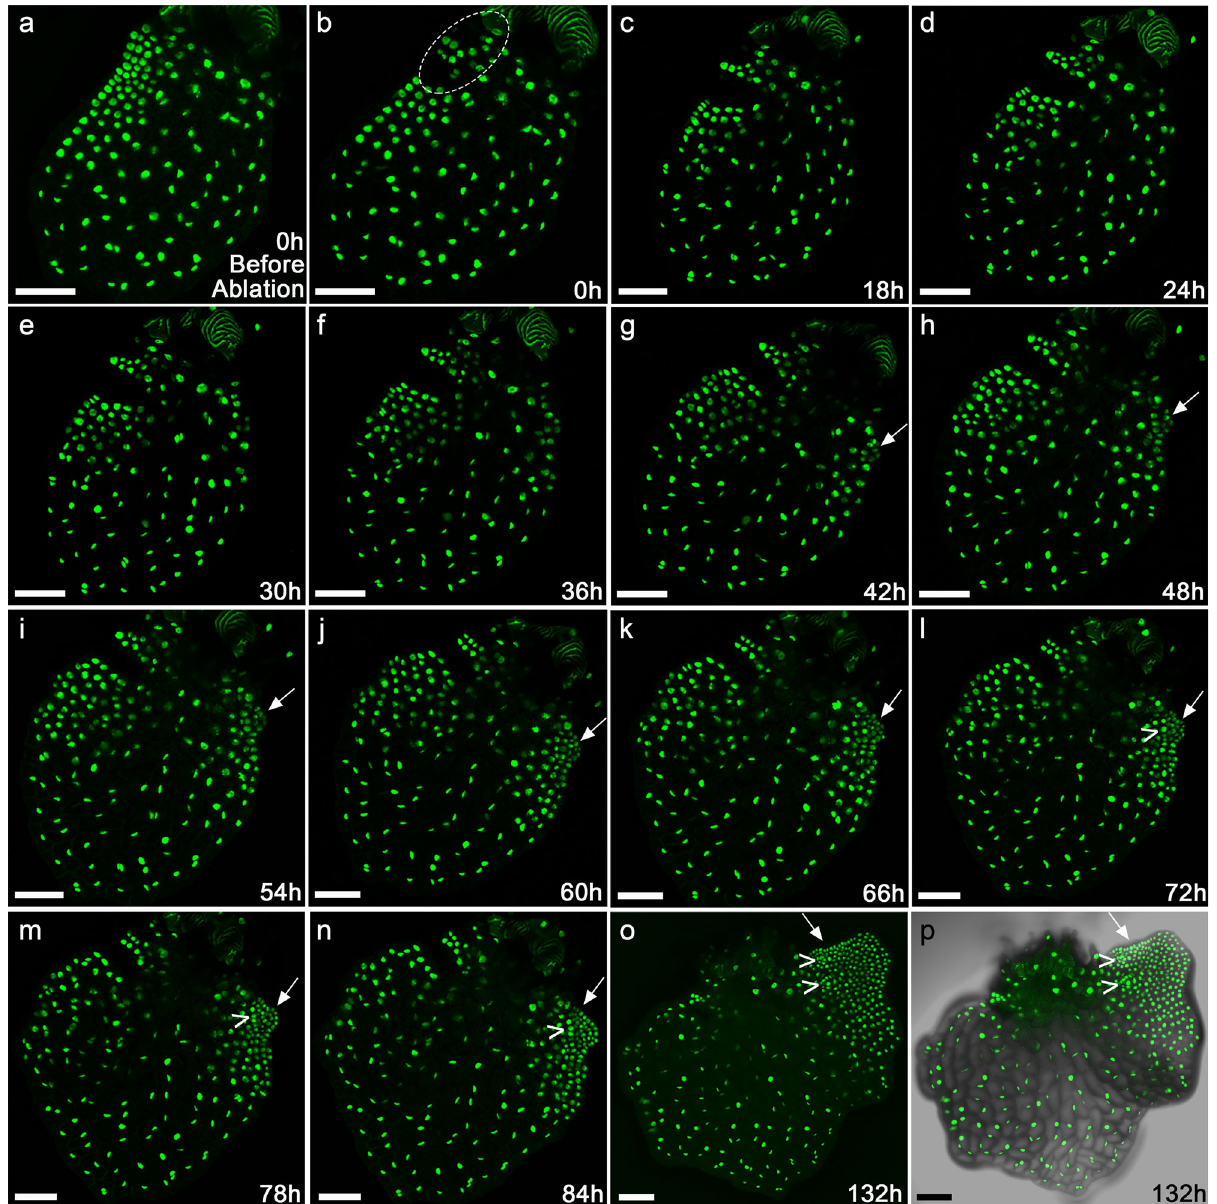
Fig. 8 Time-lapse confocal imaging of the ablation-induced new meristem formation in the Ceratopteris gametophyte. a – o The meristem in one hermaphroditic gametophyte expressing the nuclear marker H2B-GFP (at 8 DAI) was disrupted by mechanical ablation. The de novo formation of a new meristem in response to ablation was live-imaged by laser scanning confocal microscopy. a – o Z-projection views of confocal images taken at the indicated time points before ( a ) and after ( b – o ) the ablation. The time-lapse imaging was performed at the 6-hour interval, from 0 h to 132 h. The ablated area is highlighted in b . The white arrow indicates the newly initiated meristem after the ablation. The “ V ” indicates the archegonium formed adjacent to the newly initiated meristem. p Merge of the GFP ( o ) and DIC (showing the cell outlines) channels. Scale bars: 100 μ m. Three independent biological replicates were included in the mechanical ablation and time-lapse imaging experiment with the same interval and duration, all showing the de novo formation of new meristems and